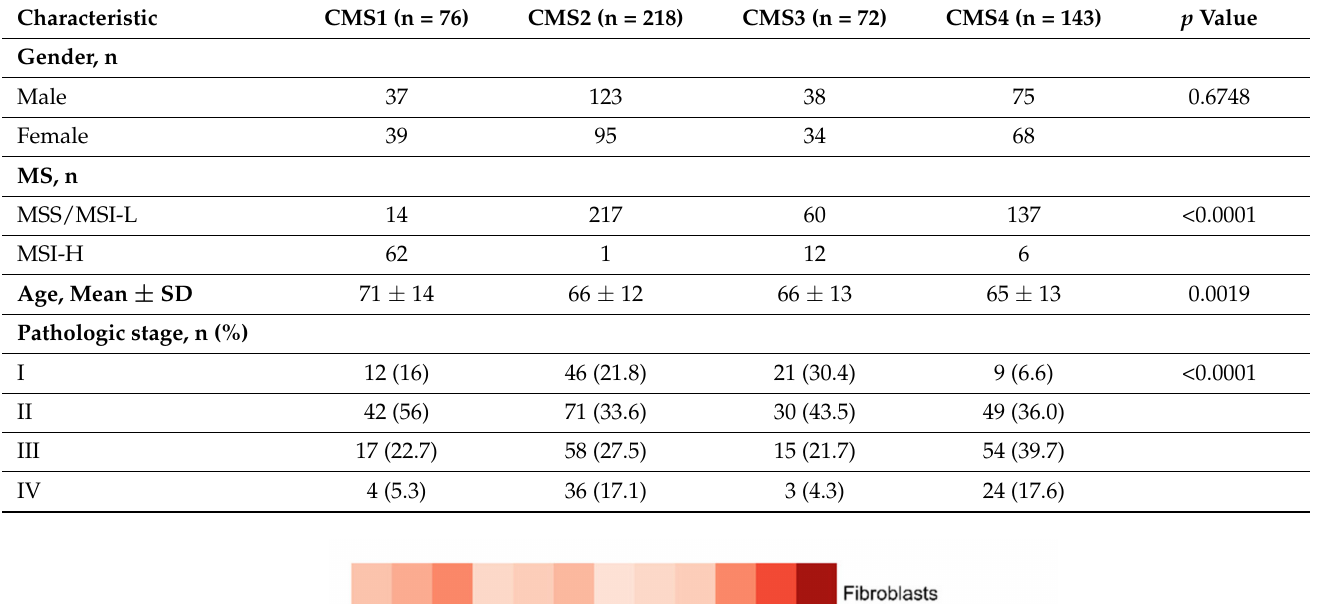
Table 1. Patient characteristics. CMS, consensus molecular subtype; MSS, microsatellite stable; MSI-L, microsatellite instability-low; MSI-H, microsatellite instability-high.